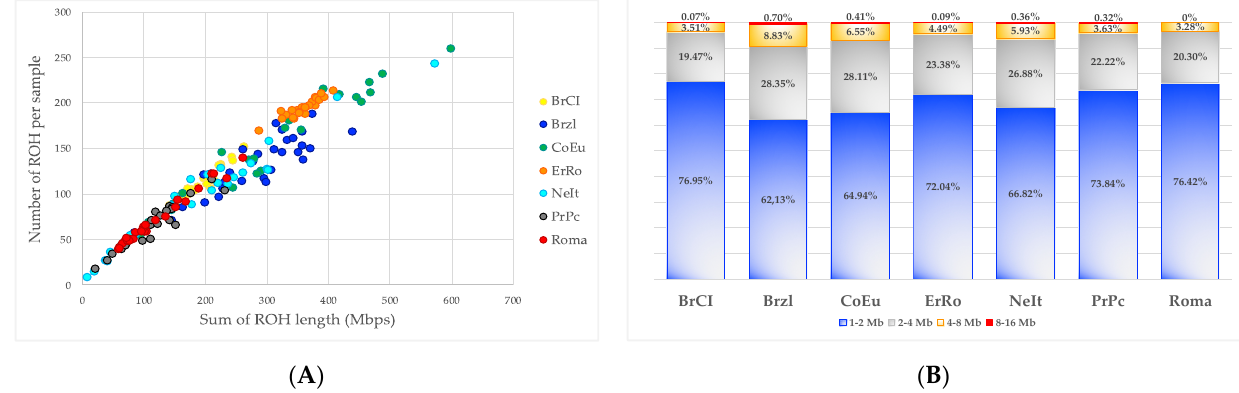
Figure 3. Breeds’ diversity based on ROH. ( A ) Relationship between the number and mean length of ROH (Mb = Mega bases); ( B ) proportion of ROH for each class of length calculated within each breed.